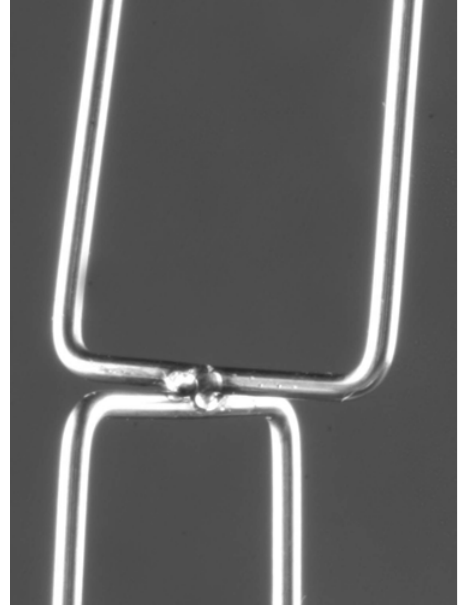
FIGURE 1- Round joints. Wire material: Forestanit in spring hard quality (diameter 0.9 mm)